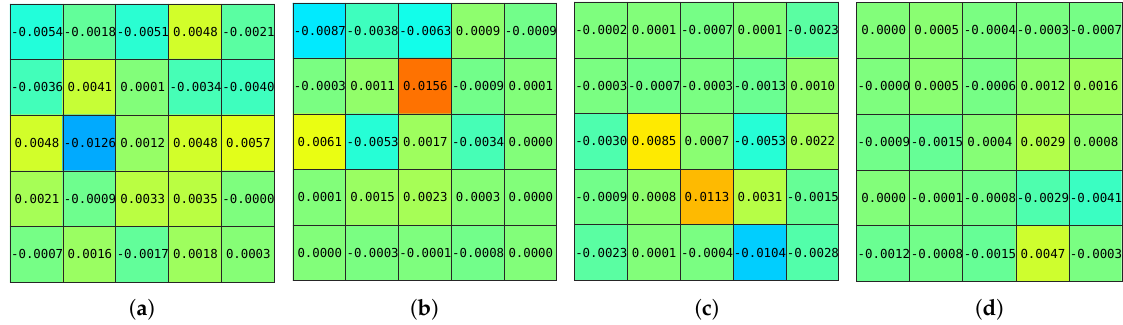
Figure 6. Compared power distribution between the mathematical model and measured values: suitable experimental setup in Table 2 is ( a ) setup #1, ( b ) setup #2, ( c ) setup #3, and ( d ) setup #4.